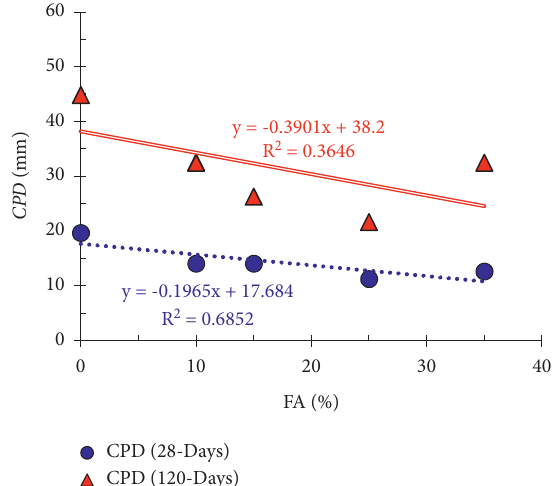
Figure 21: Relationship between FA content in the binder and corresponding CPD values of HSC.